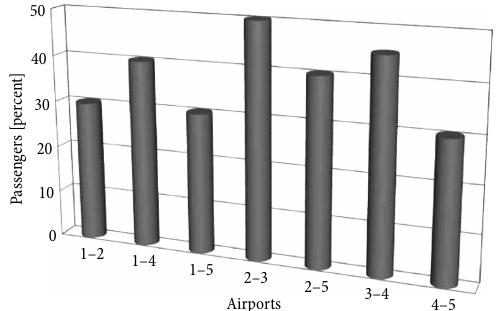
Fig. 2. Potential loads of passengers (contingents) in percent of total airplane capacity